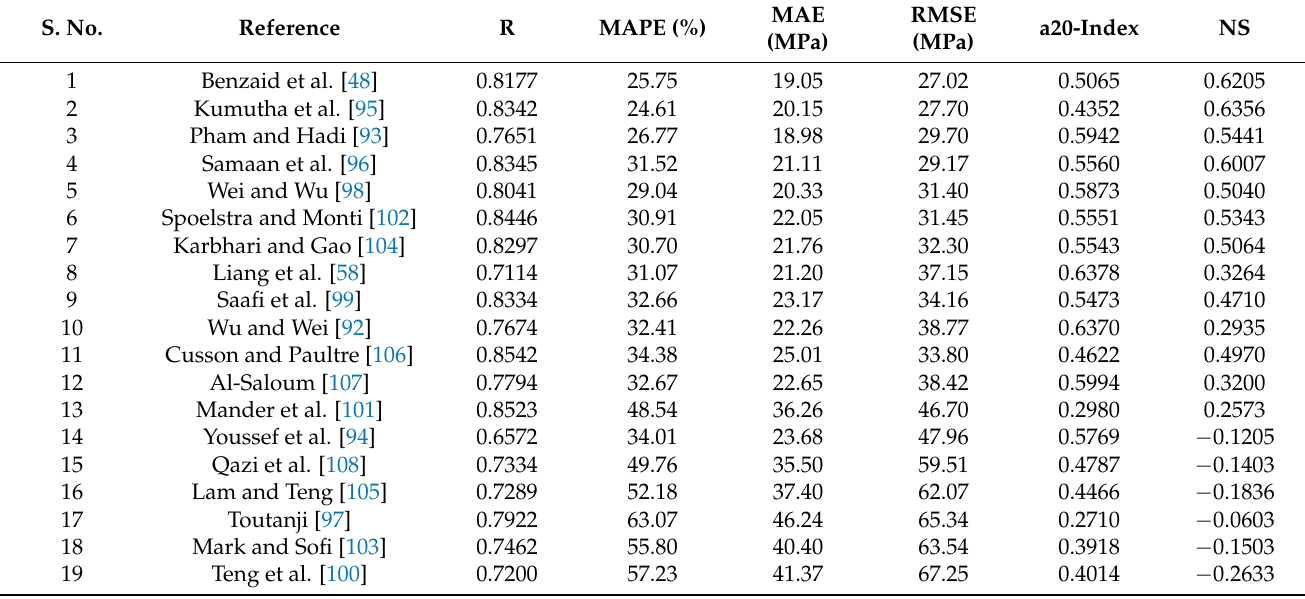
Table 4. Statistical indicators of analytical